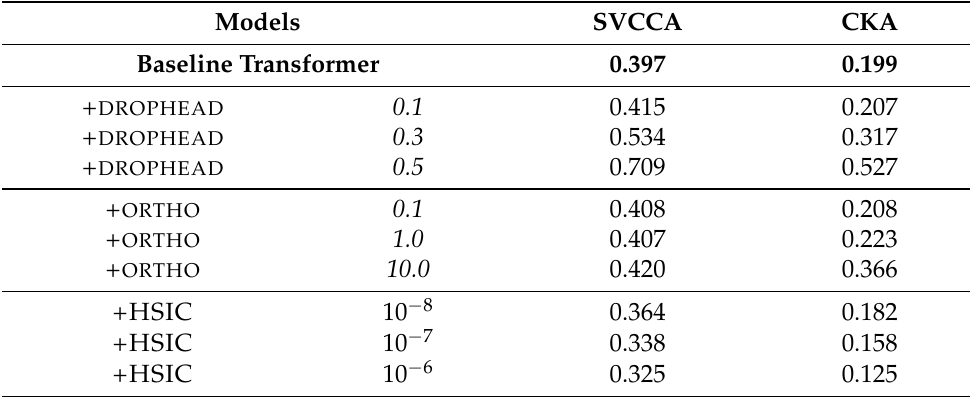
Table 5. Controlled inter-head similarity with suggested